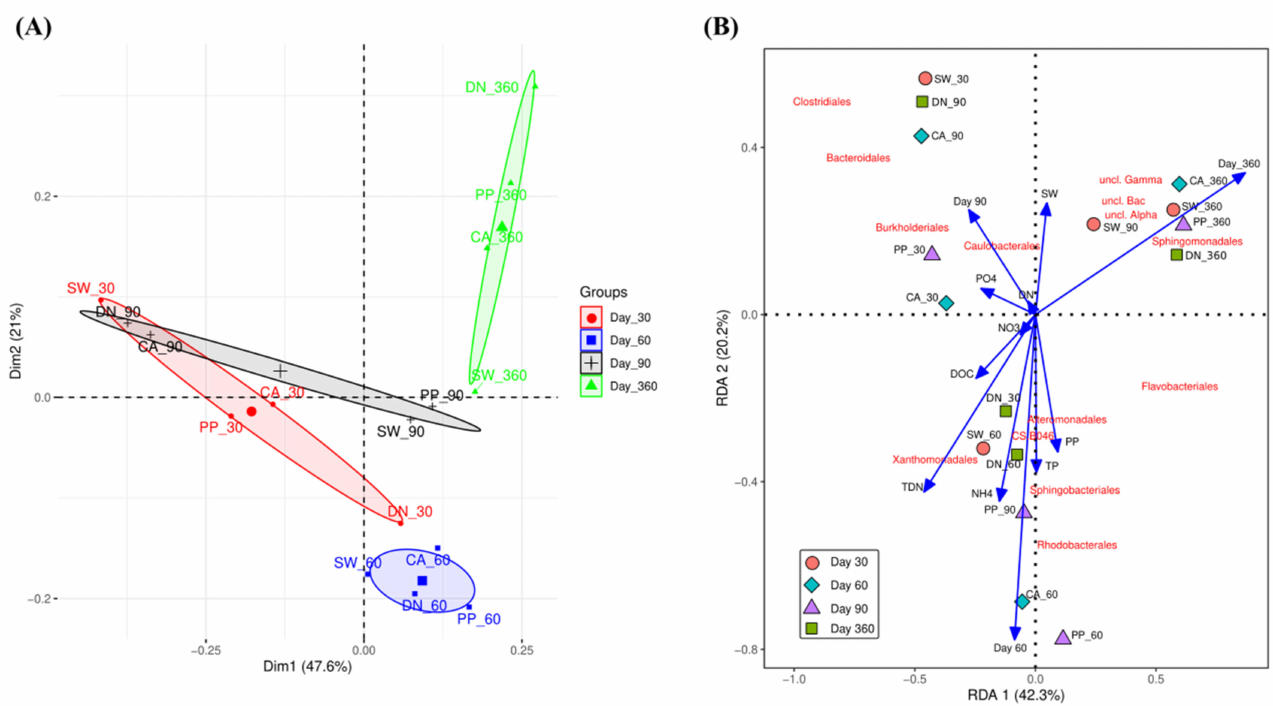
Figure 3. PCA ( A ) and RDA ( B ) ordination for different antiscalants and for different incubation